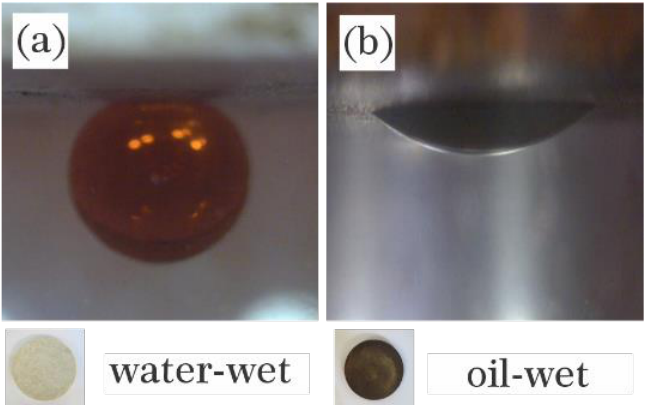
Figure 4. Images of carbonate thin sections ( a ) before and ( b ) after aging in crude oil correspond contact angles.